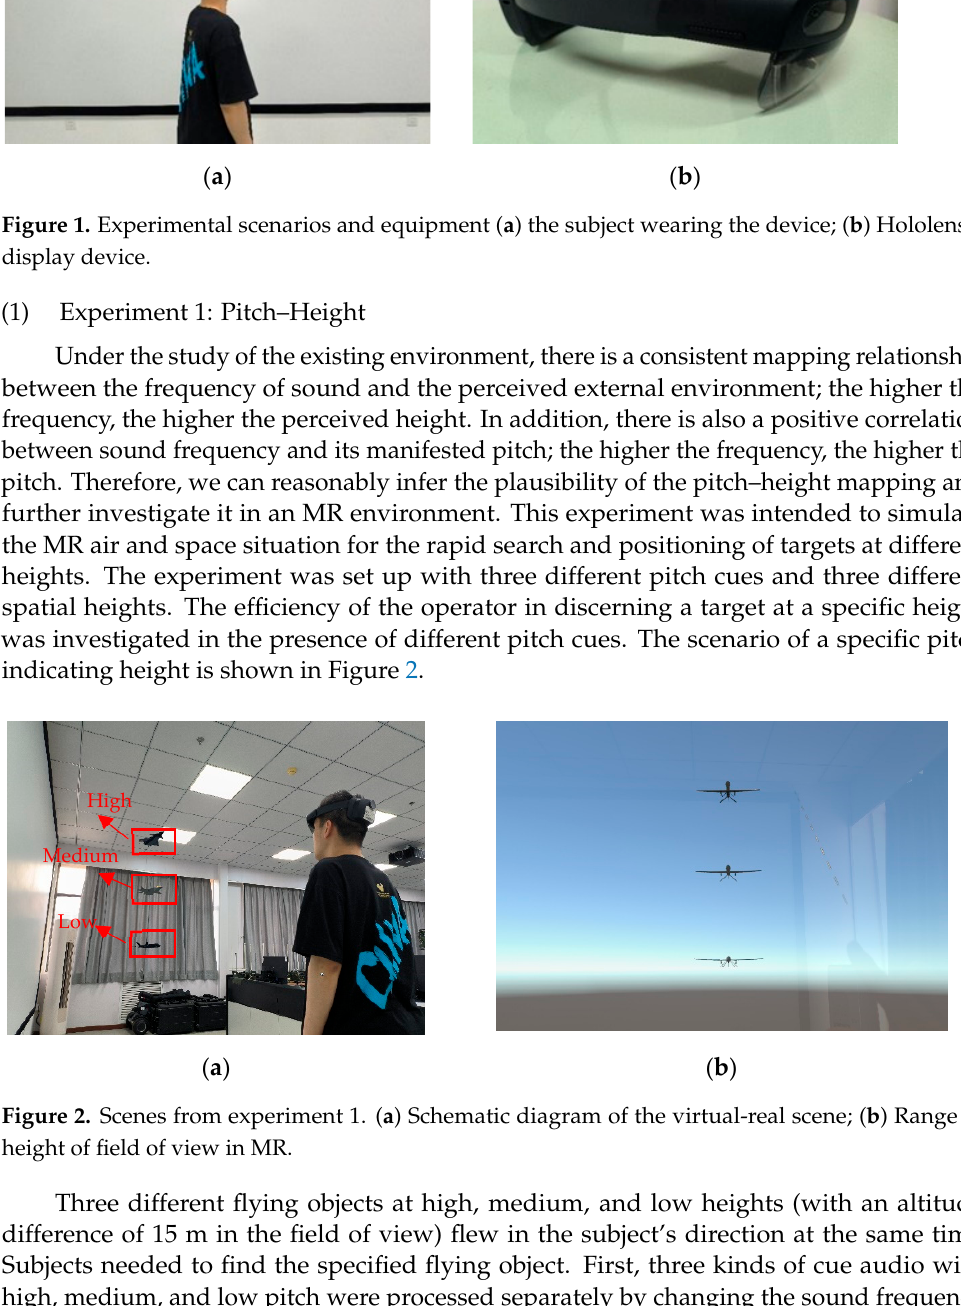
( b ) Figure 3. Scenes from experiment 2. ( a ) Schematic diagram of the virtual-real scene; ( b ) Range of distance of field of view in MR. Combined with the variability of the virtual and actual ranges, this experiment se- lected a scale of 1:1 in unity3D, that is, 1 unit distance in unity3D corresponds to 1 m of actual distance. Three targets with different distances (15 m, 30 m, and 50 m) from the human eye were placed at the same height (field-of-view height 30 m) and in the same direction. In order to correspond to the volume attenuation in the above realistic environ- ment, different volumes were set at the corresponding positions of the targets to indicate the targets (the volumes were V, V-6, V-10.5). With audio instructions at different vol- umes, subjects judged the target location visually and then selected the correct target to complete a set of experiments. The experiment started with an initial value of V = 50 dec- ibels (dB), then the corresponding volumes at three different locations were 50 dB, 44 dB, and 39.5 dB. Of these, half of the subjects performed nine experiments (three random dis- plays for each distance) with auditory distance cues. The remaining half of the subjects completed the above experiments without auditory distance cues. A total of 48 sets of data with correct judgment results were obtained.